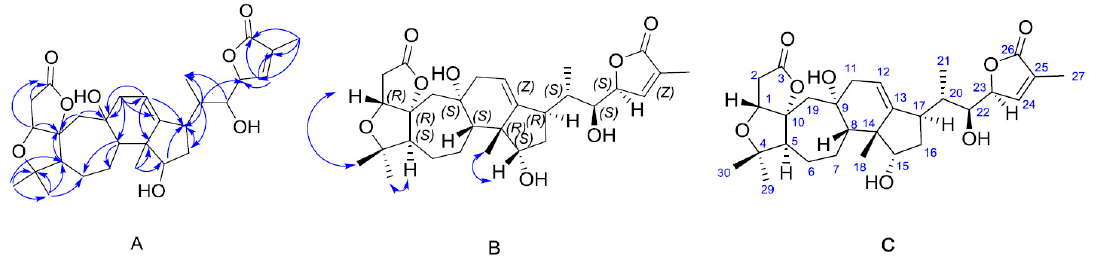
Figure 1. Key HMBC ( A ), NOESY ( B ) correlations of micrandilactone H ( C ).